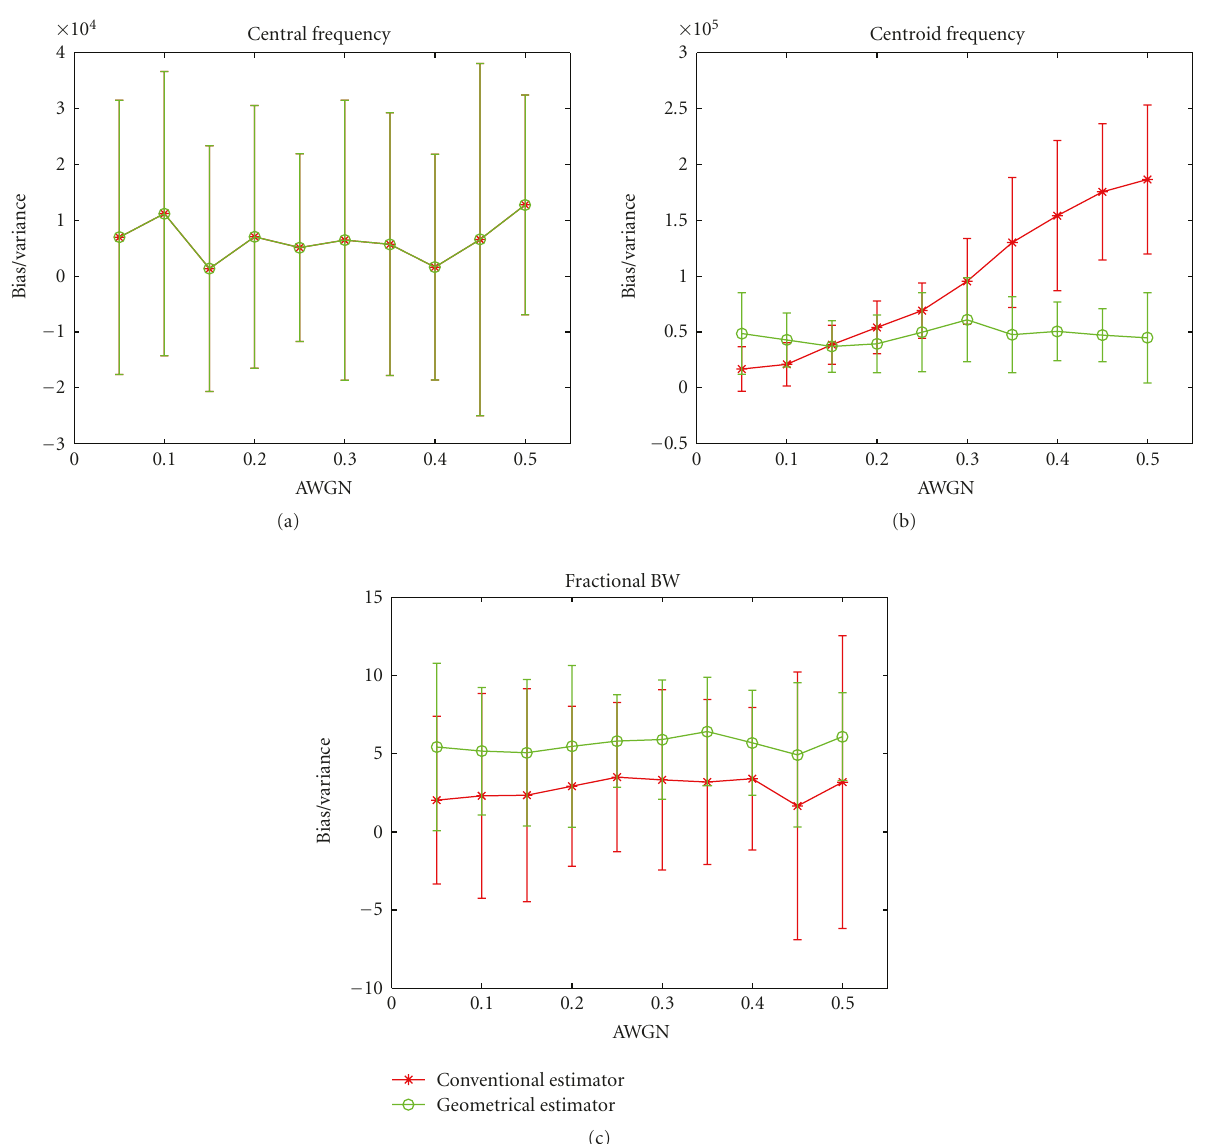
Figure 6: Central Frequency, Centroid Frequency, and Fractional BandWidth operators variance and deviation from the theoretical result (bias). Simulation parameters for LTV were mean scatterer diameter D = 0 . 5mm, AWGN of variance varying from 0.05 to 0.5. Bias (marker “ ∗ ” or “o”), and variance (vertical bars).